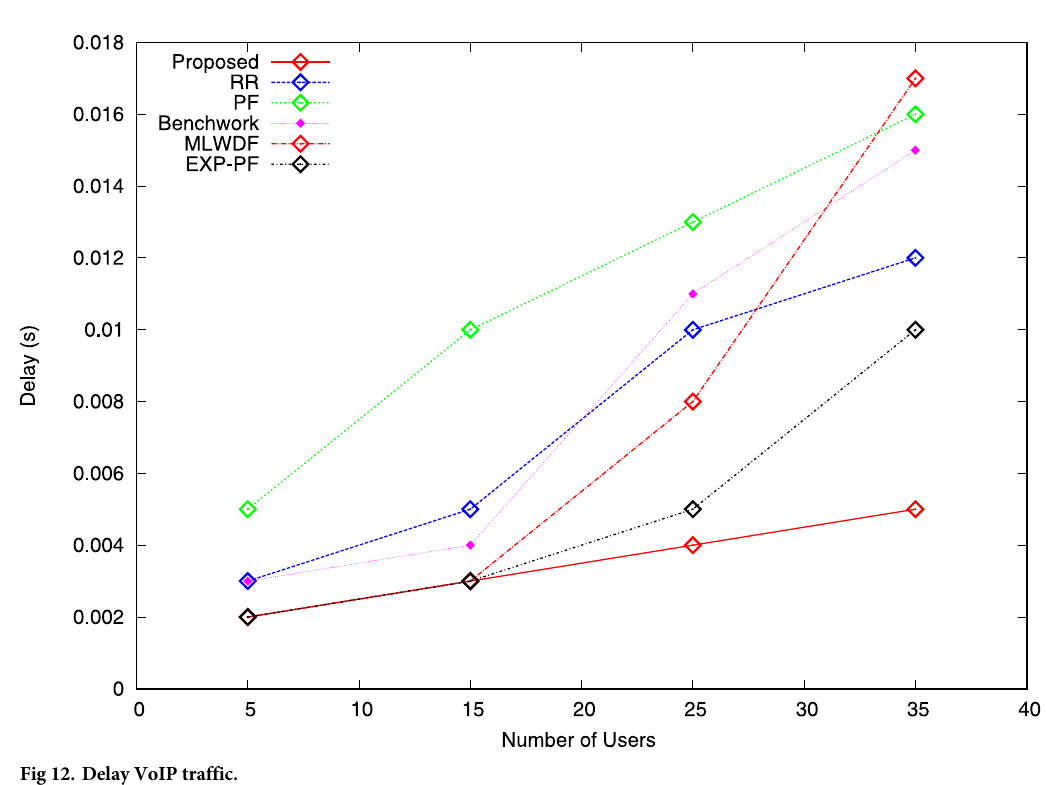
Fig 12. Delay VoIP